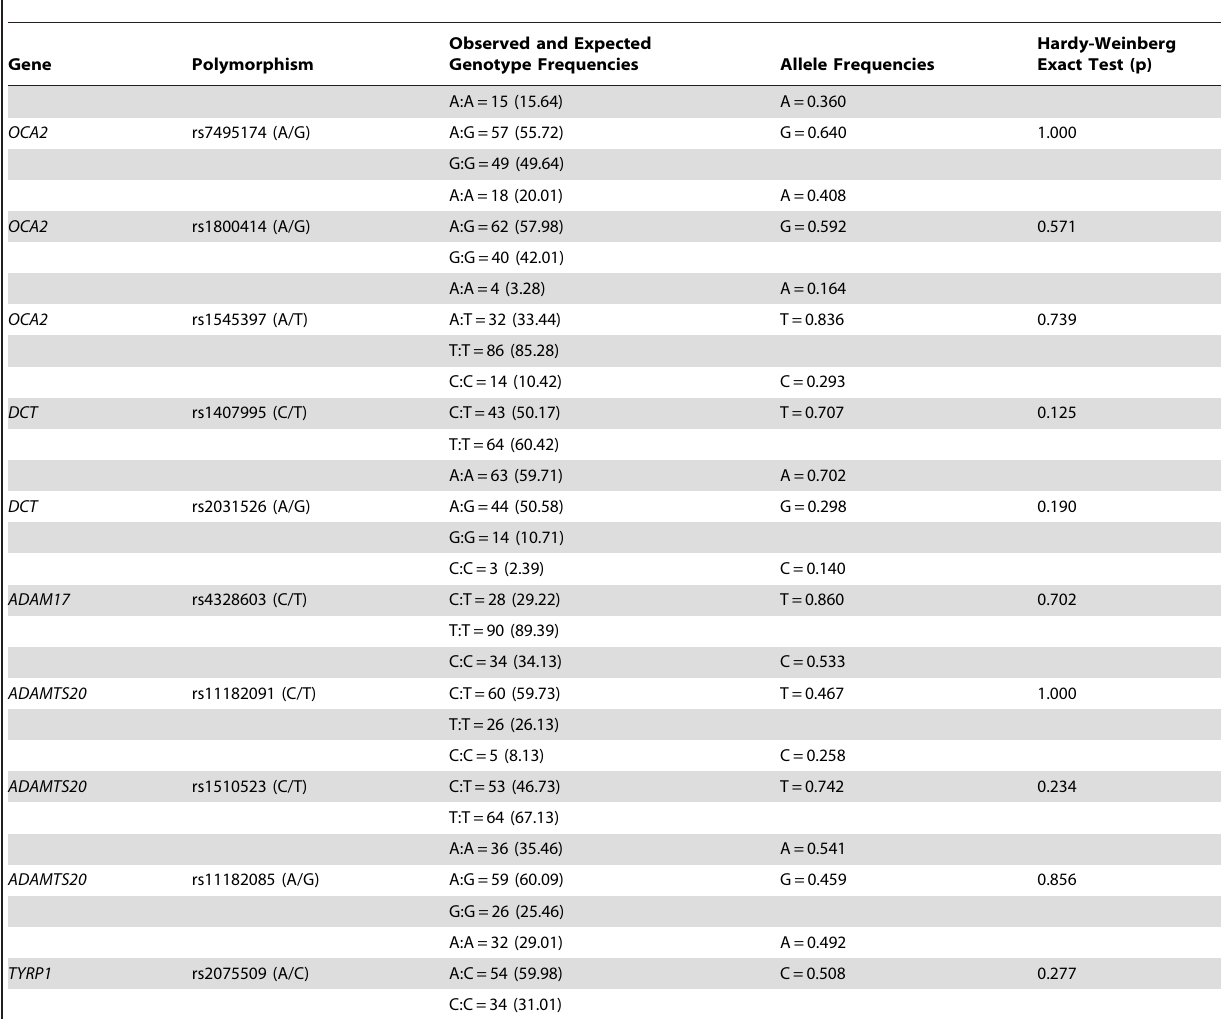
Table 2. Observed and expected genotype frequencies, allele frequencies, and the Hardy-Weinberg exact test for 10 SNPs in the Canadian East Asian